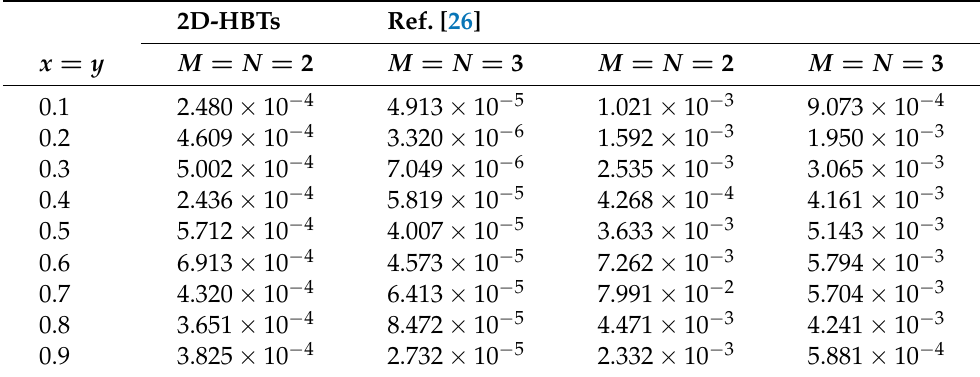
Table 5. The maximum absolute errors for λ 1 = λ 2 = 0.95 in Example